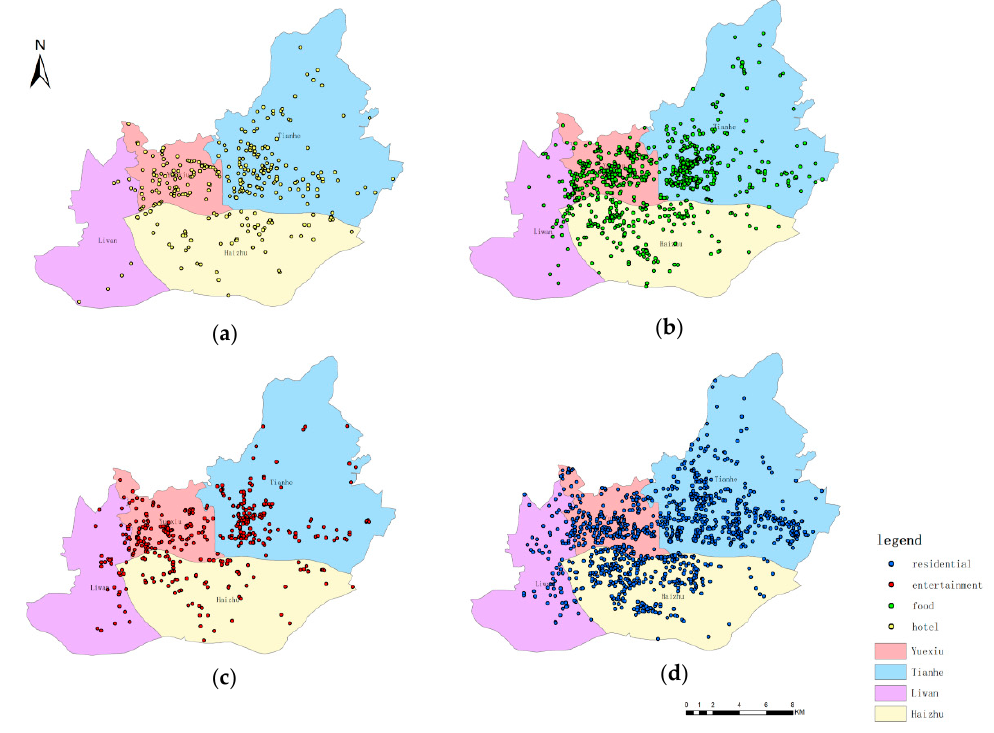
Figure 7. The space distributions of four POI categories; ( a ) represents the hotel distribution; ( b ) represents the food distribution; ( c ) represents the entertainment distribution, and ( d ) represents the residential distribution.